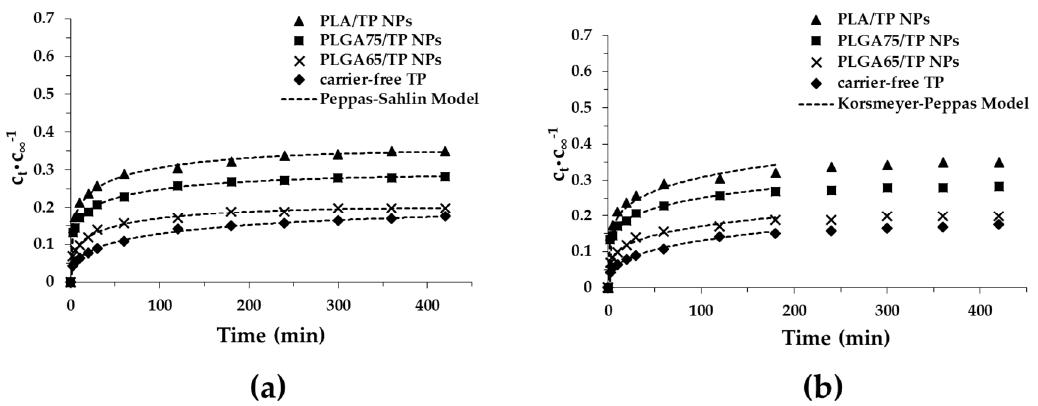
Figure 8. Release profiles and different kinetic models-predicted (Peppas-Sahlin model ( a ), Korsmeyer-Peppas model ( b )) for the release curves of TP from PLA and PLGA NPs in the PBS buffer (pH = 7.4, 0.9 w / w % NaCl)